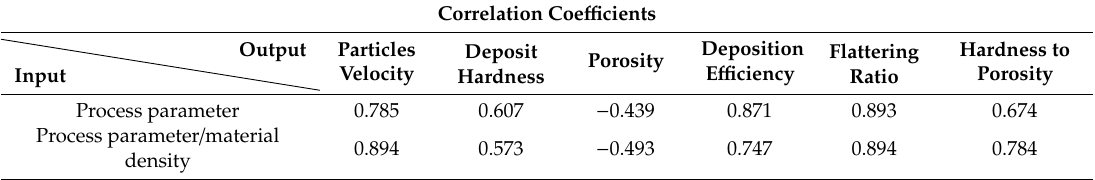
Table 6. Correlation behavior among the process parameter and the coating